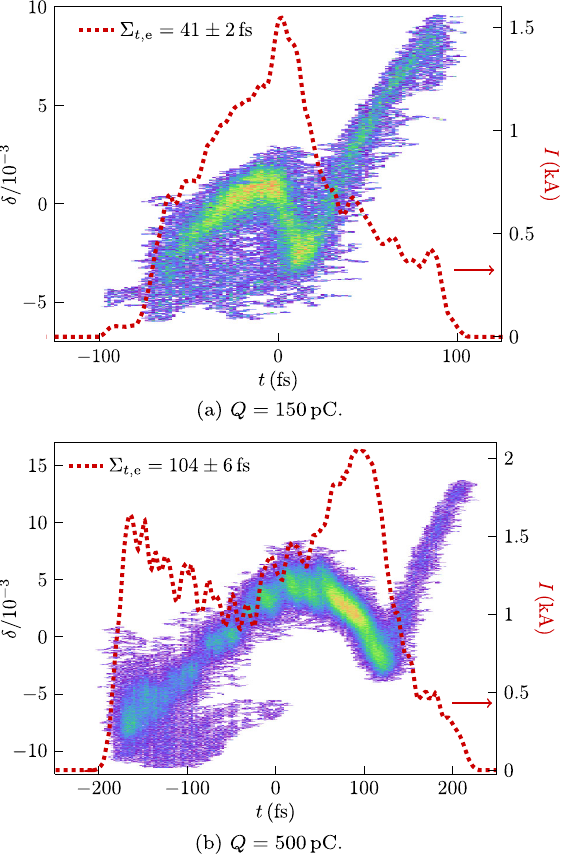
lengths.FIG. bunch current (dotted red lines) measurements using the TDS in combination with the energy spectrometer for bunch charges of (a) 150 pC and (b) 500 pC. The selected single shots represent typical bunches out of 50 measurements, and the rms bunch length values ( (cid:2) t; e ) including measurement error in the legends correspond to the shown single